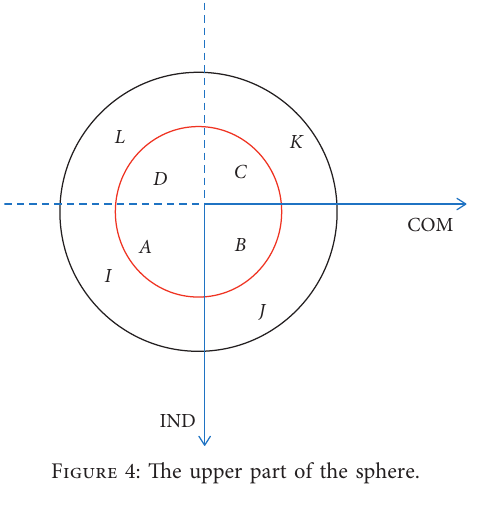
Figure 4: The upper part of the sphere.